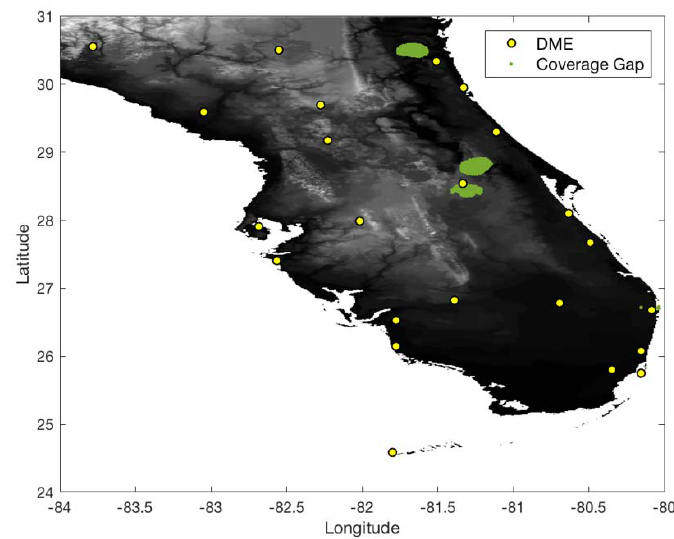
Figure 11. DME/DME positioning accuracy gaps of 92.6 m with DME/S and the current DME ground network.